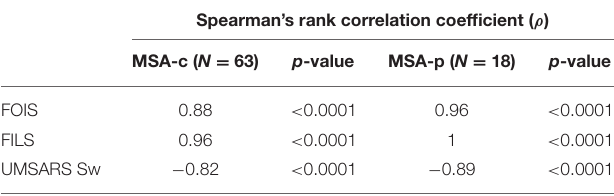
TABLE 2 | Spearman’s rank correlation coefficients between the Neuromuscular disease Swallowing Status Scale and other dysphagia clinical scales. Spearman’s rank correlation coefficient ( ρ )